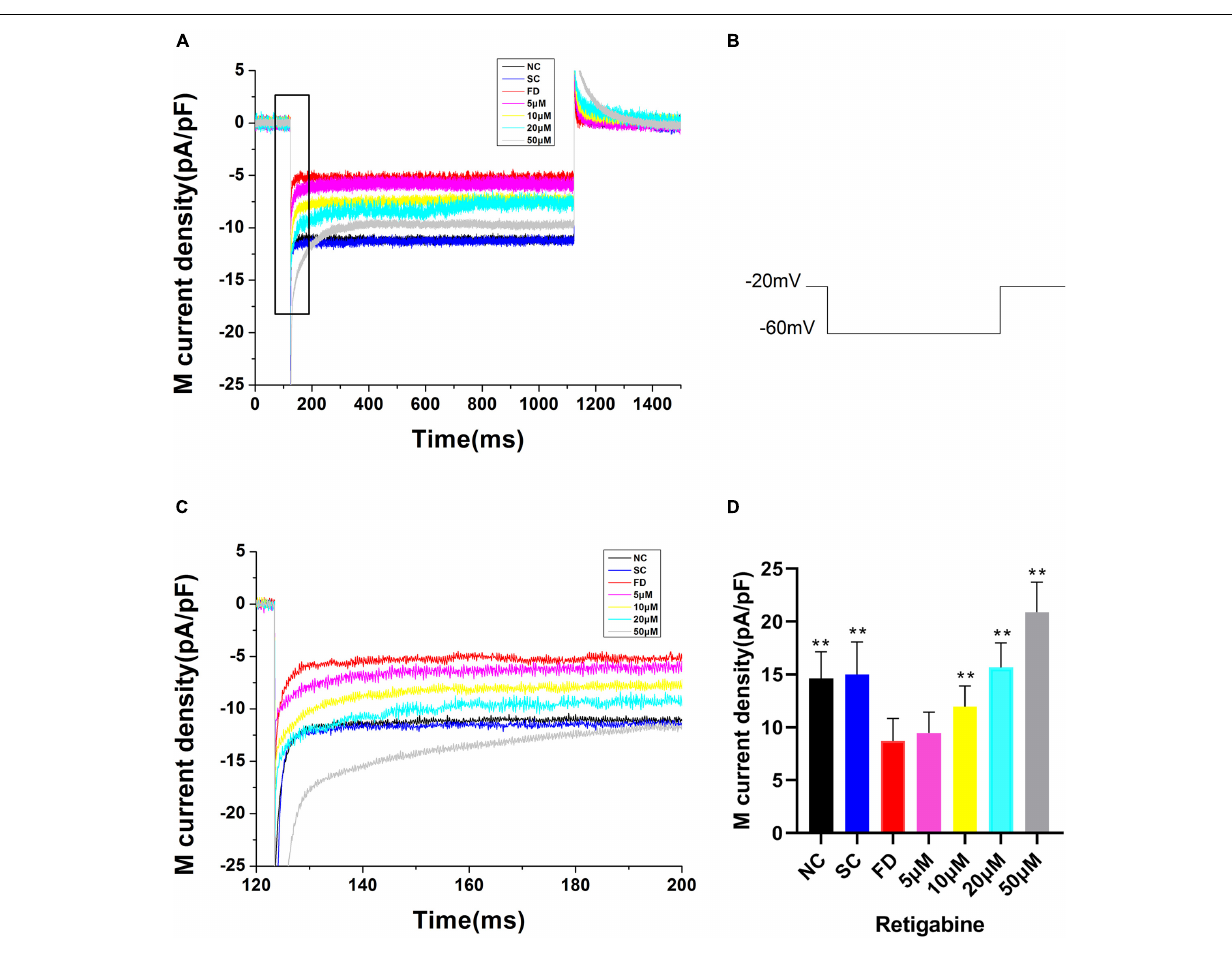
Frontiers in Physiology |